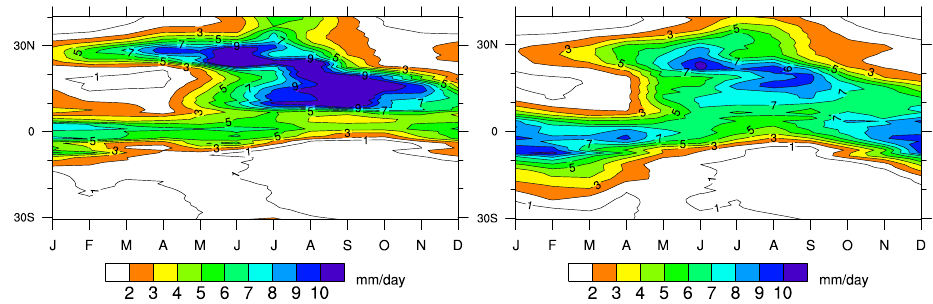
Fig. 3. Annual cycle of precipitation averaged between 107 ◦ –122 ◦ E. Units: mmday − 1 . (Left) HiGAM and (Right) GPCP.